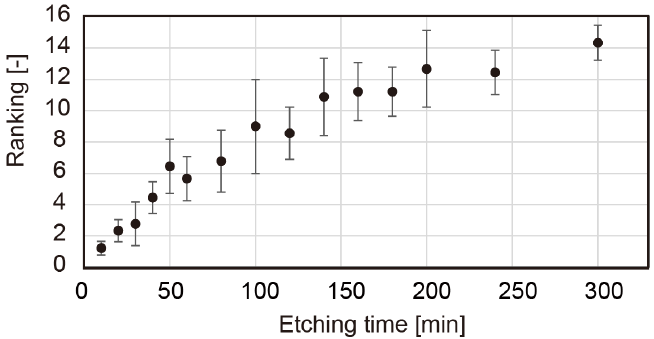
Figure 5. Ranking of dry perception for various etching times.